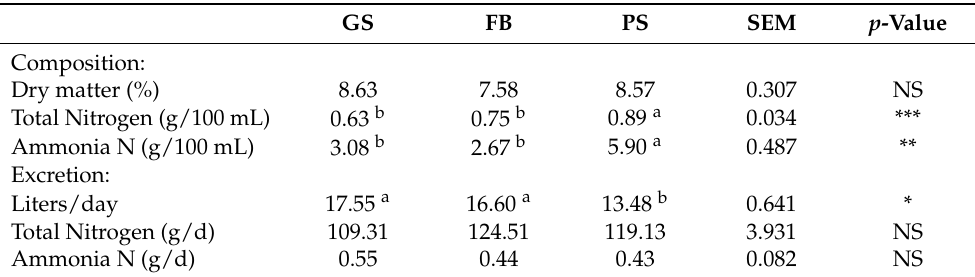
SEM, standard error of means. NS, not significant. Table 9. Composition of urine and urine excretion by dairy cows fed diets based on grass silage (GS), faba bean silage (FB), or field pea silage (PS). GS